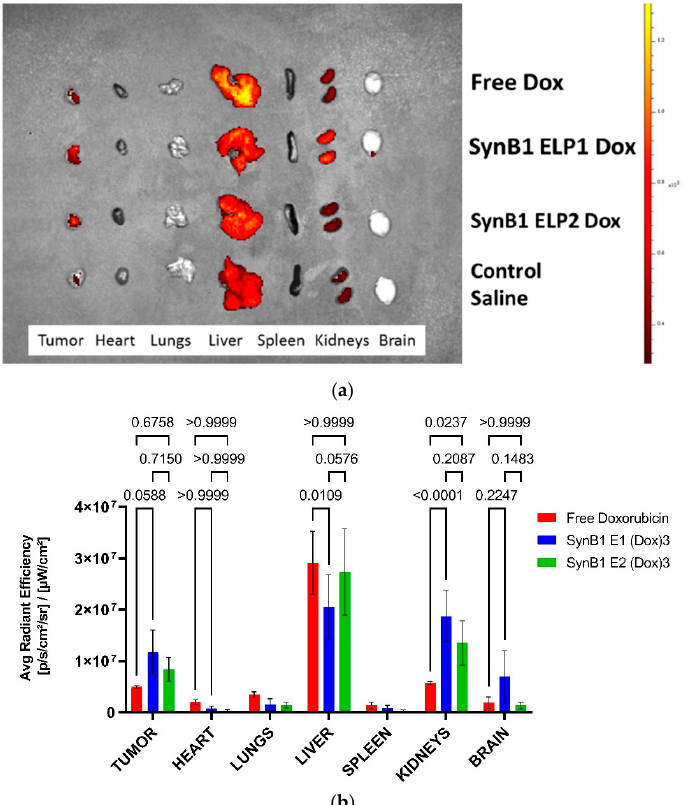
Figure 3. Biodistribution of dox in MDA MB 231 tumor-bearing mice. ( a ) Representative ex vivo fluorescent images of DOX signal accumulated in tumors and organs following intravenous injection of mice with free dox, SynB1-ELP1-DOXO and thermally non-responsive control SynB1-ELP2-DOXO, ( b ) Quantification of dox fluorescent signals in region of interests (ROIs) for tumor and organs, 2 h after